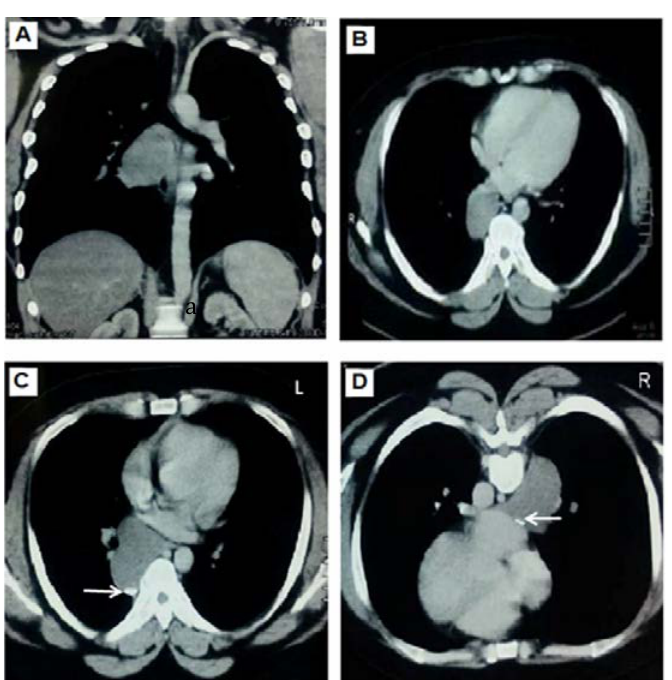
Figure 1. Contrast enhanced chest CT with non-enhancing sub-carinal bronchogenic cyst in the posterior mediastinum: axial view (A), and coronal view (B), with posteriorly located calcific focus (arrow) on supine position (C), which changes its location anteriorly (arrow) on prone position